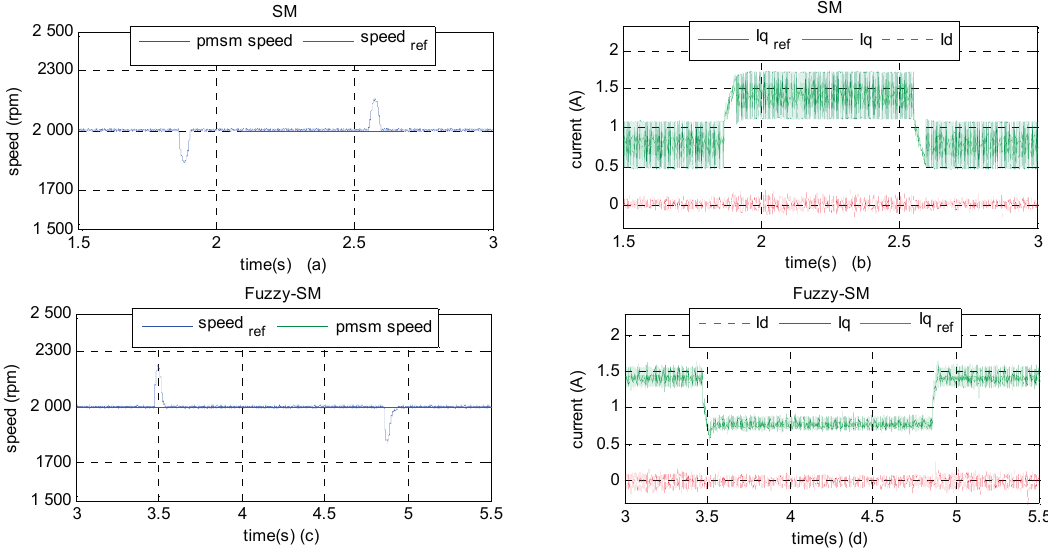
Figure 8. Experimental results of load disturbance at 2000 rpm. ( a , c ) SMC and Fuzzy-SMC speed; ( b , d ) direct, quadratic and reference currents for the developed